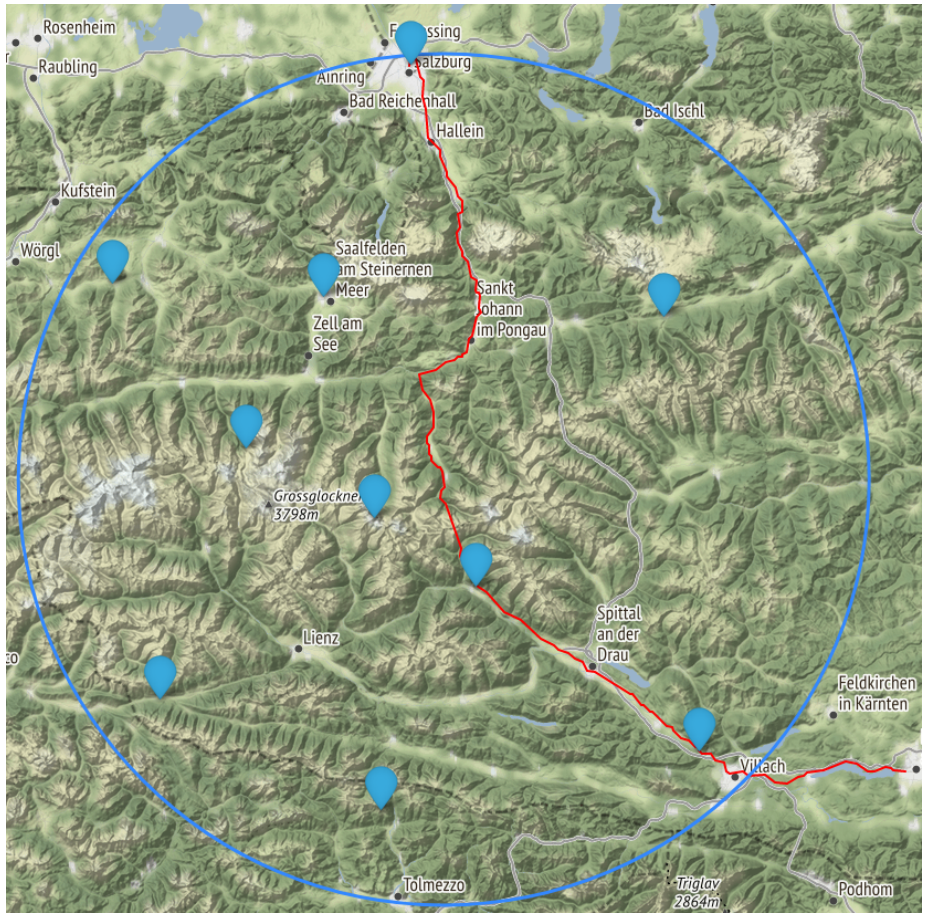
Figure 3. Train track investigated in CS1 (Salzburg–Klagenfurt), derived from CSRS-PPP processing. Indicated in blue are the EPOSA stations used for calculating the SEID model parameters.